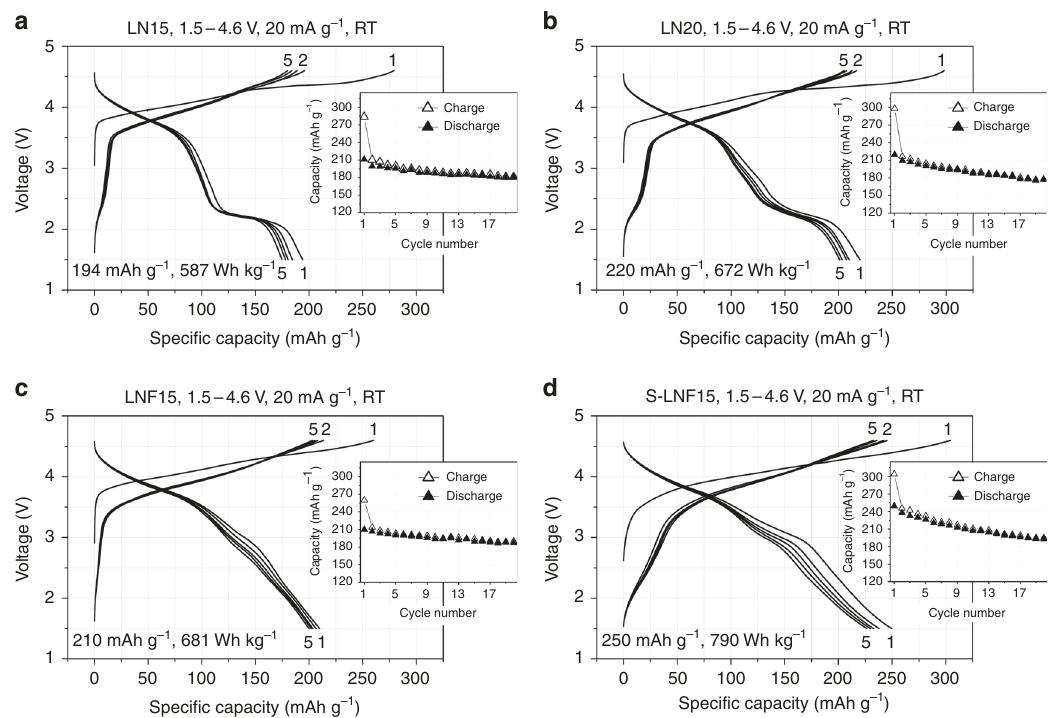
Fig. 4 Cycling performance of Li 1.15 Ni 0.375 Ti 0.375 Mo 0.1 O 2 (LN15), Li 1.2 Ni 0.333 Ti 0.333 Mo 0.133 O 2 (LN20), and Li 1.15 Ni 0.45 Ti 0.3 Mo 0.1 O 1.85 F 0.15 (LNF15). Voltage pro fi les of a LN15, b LN20, c LNF15, and d shaker-milled LNF15 (S-LNF15) when cycled between 1.5 and 4.6 V at 20 mA g − 1 at room temperature. The inset shows the capacity retention of the materials over the fi rst 20